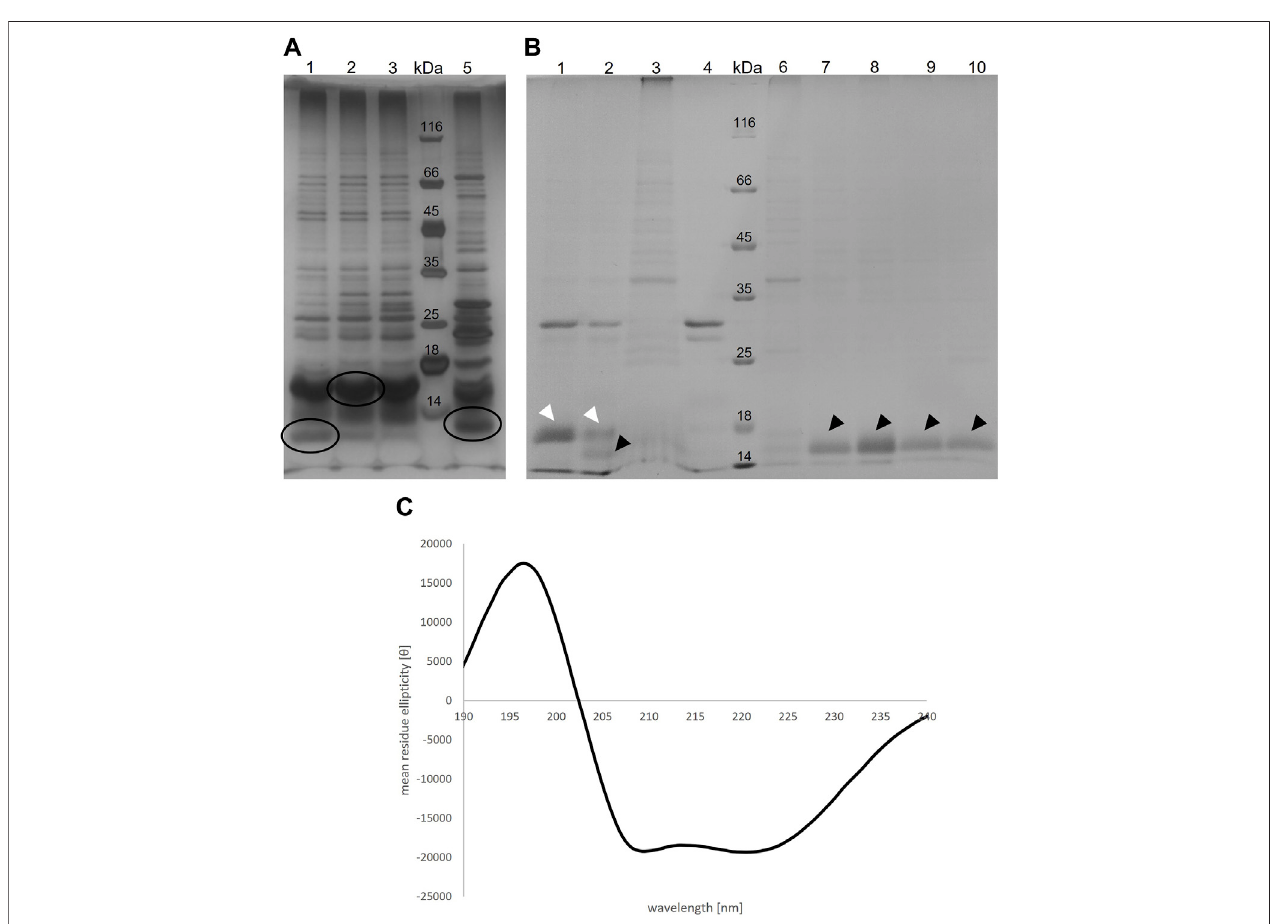
FIGURE4 |(A) Silver-stained 12%SDS polyacrylamide gel of theelution fractions from IMACofthe TraB 31-110 test puri fi cation withtwo different E.coli expression strains. Forlane1-3 BL21 Codon Plus RIL cells were used, for lane5 BL21 star cells. Lane 4 shows the MW standard (Thermo Fisher Scienti fi c). Circled bands were cut out and applied to MS analysis (B) Coomassie-stained 12% SDS polyacrylamide gel showing different puri fi cation steps of TraB 31-110 . Lane 1: pooled elution fraction of the IMAC; lane 2: same fractionsafter TEV cleavage; lane 3and 4:elutionfractions ofthe reverse IMAC; lane5: MWstandard (Thermo Fisher Scienti fi c); lane6 – 10: elution fractions of the SEC using a Superdex 200 increase column. White arrow heads point at uncleaved TraB 31-110 . Black arrow heads point at TEV-cleaved TraB 31- α -helical conformation of TraB 110 . (C) CD spectrum of TraB 31-110 showing two minima at 209 and 222 nm implying a mainly 31-110